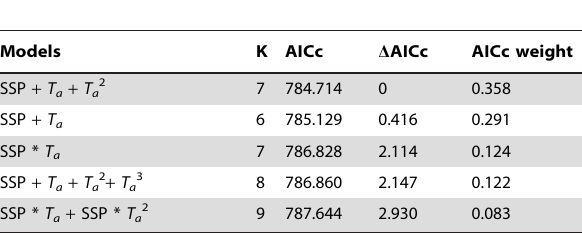
Figure 3. Heat loss through the bill. Total heat loss ( Q bill ) is shown in (A) and the percent of total heat loss through the bill (percent Q bill ) is shown in (B). Black lines=model averaged predictions of linear mixed models 6 unconditional standard errors. Gray lines=raw data.